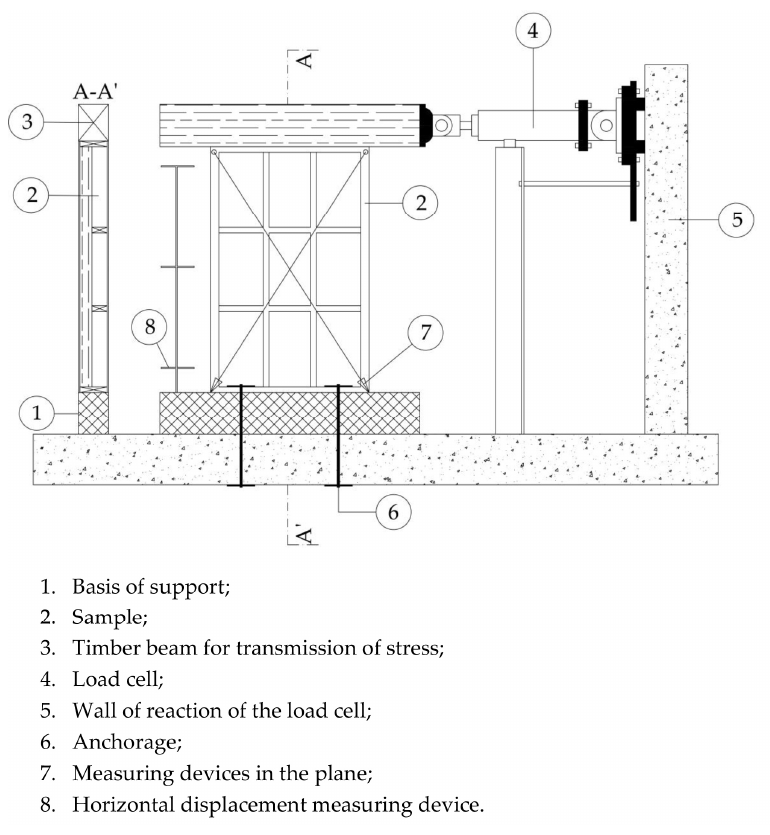
Figure 4. Test setup and instrumentation.